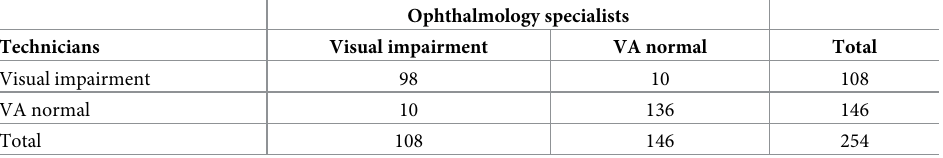
Table 2. Diagnostic properties of assessment of visual acuity by doctors (gold standard) and nursing technicians. Ophthalmology